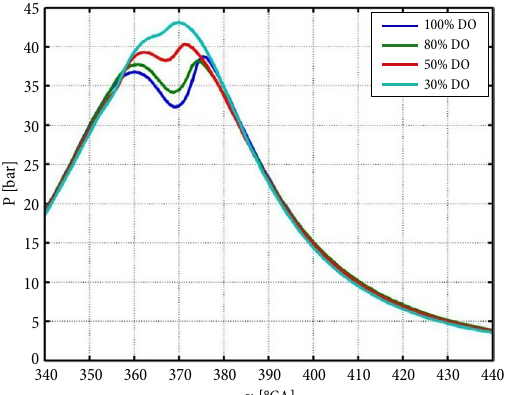
Fig. 3. Average recorded pressure versus CA for dual-fuel operation; n = 1500 rpm; T = 50 Nm (at different proportions of diesel oil)